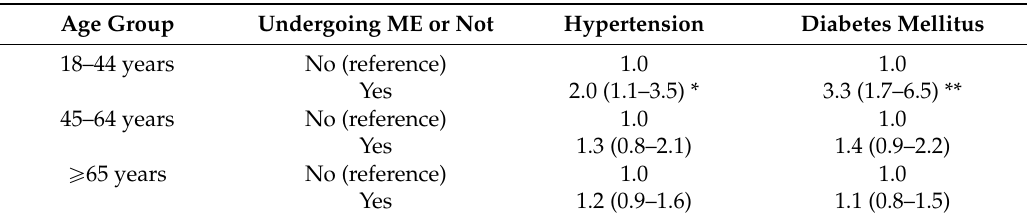
Table 3. Associations of undergoing a medical examination (ME) with prevalence rates of hypertension and diabetes mellitus (Hunan of China,